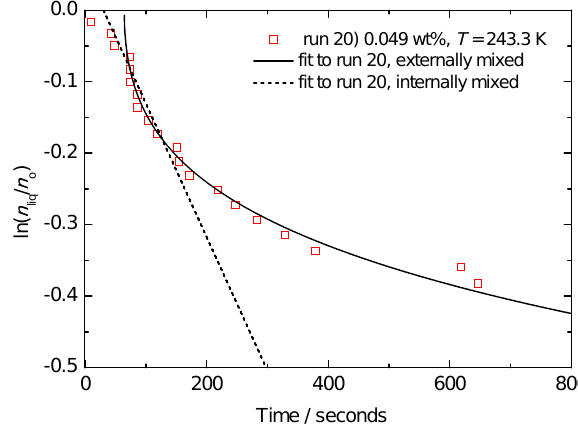
Fig. 12. Model fits to the experimental decrease in the fraction of Fig. 11. Theoretical f ice (T ) curves for droplets containing ex- droplets which were liquid ( n liq / n o = 1- n ice / n o ) with time at con- ternally mixed nucleation sites with a normal distribution of ice- stant temperature for run 20. The model lines were calculated by nucleating abilities, which were characterised by ln( J i (T )) = - aT + assuming that the droplets contained a different mixture of nucle- b i . The theoretical f ice curve for a cooling rate of 0.8 K min − 1 was ation sites (externally and internally mixed) which was described fitted to the experimental run 13a, using a least squared technique by a normal distribution. The parameters used were as follows: for to minimise µ b and σ 2 where a was fixed at 15. Using the same b the externally mixed model a = 15, µ b = 3659, σ 2 = 40 . 2) we then calculated the fit parameters ( µ b = 3637.7 and σ 2 b the internally mixed model, a = 15, µ b = 3617.5, σ 2 f ice curve for a cooling rate of 7.5Kmin − 1 which falls well within also fitted an offset to the time to take into account any delays in the spread of the experimental data. This shows that the multiple temperature equilibration of the droplets with the stage, hence the component stochastic model with a large value of a can reproduce model fits start at positive the cooling rate independence.